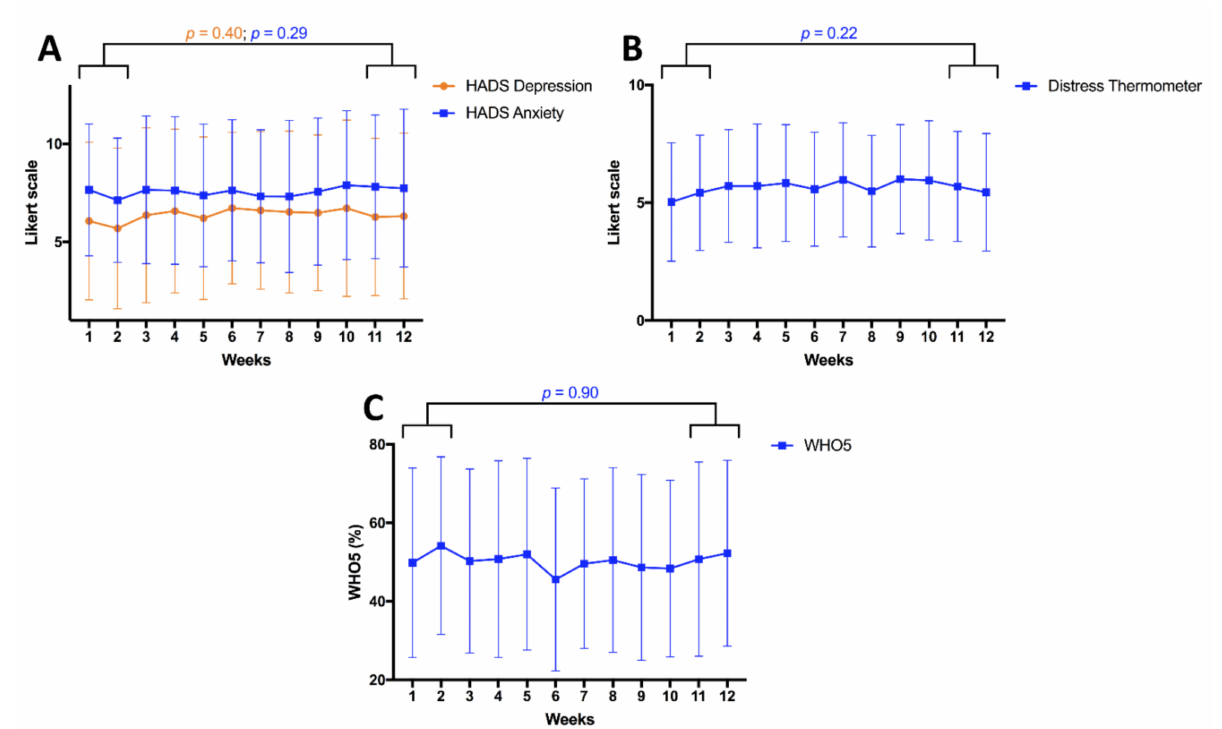
Figure 3. There were no changes over time for the four main outcomes of depressive symptoms and anxiety measured using the Hospital Anxiety and Depression Score (HADS); ( A ), the distress thermometer ( B ), and the WHO5 well-being score ( C ). Results are demonstrated for all participants (n = 100) and any participant who completed a questionnaire at the relevant timepoint was included. A graph depicting results for patients and relatives separately can be found in Figure